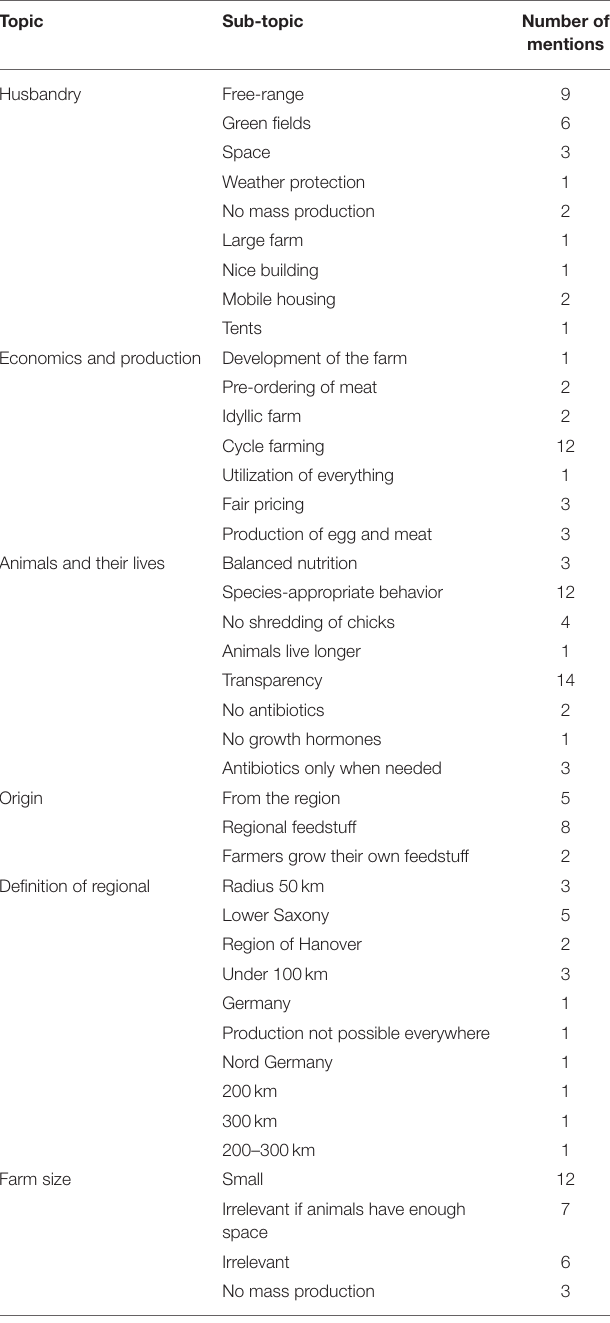
TABLE 1 | Topics and sub-topics built from the group discussions of the “ideal chicken farm.”